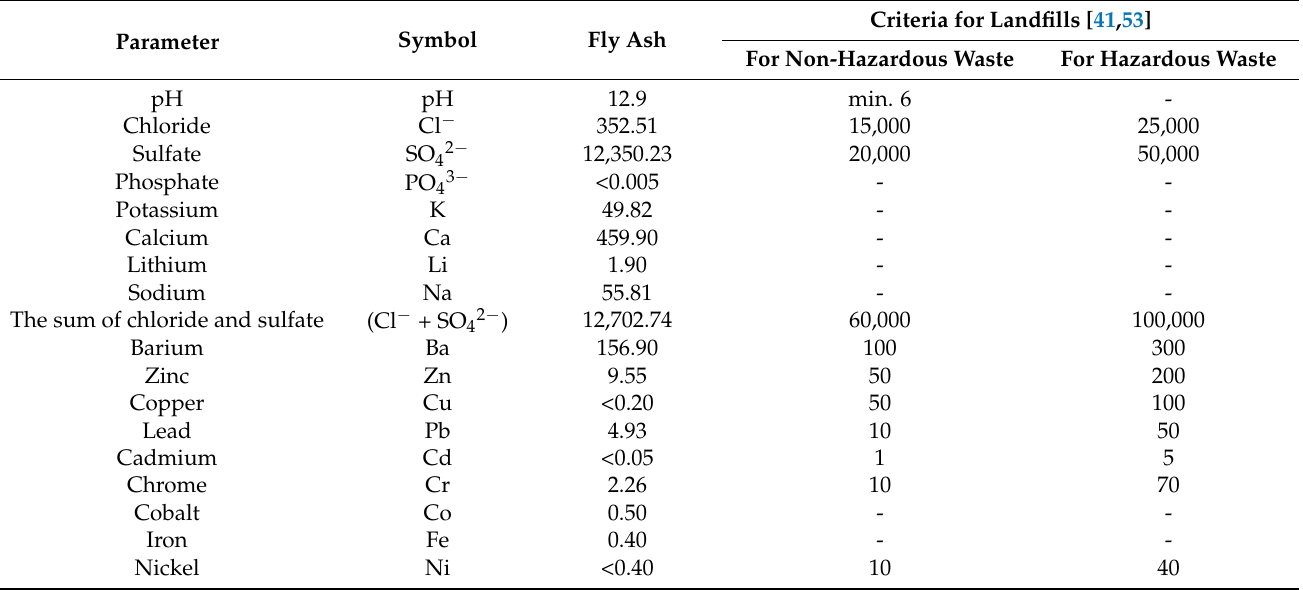
Table 4. Leachability of hazardous substances and heavy metals from fly ash, expressed in